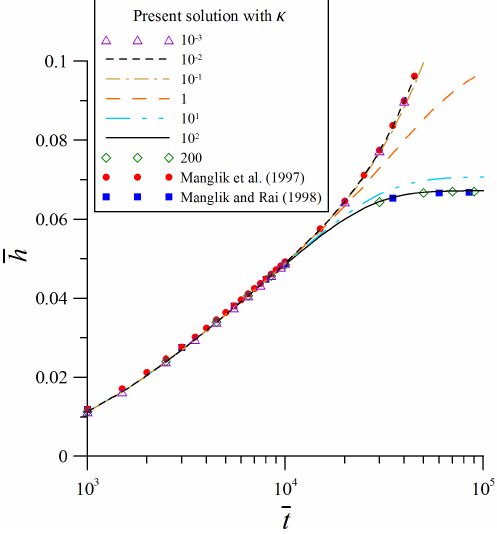
Figure 2. Temporal distributions of the dimensionless head pre- dicted by the Manglik et al. (1997) solution for a no-flow boundary, the Manglik and Rai (1998) solution for a Dirichlet boundary, and the present solution with κ z = 1 for a Robin